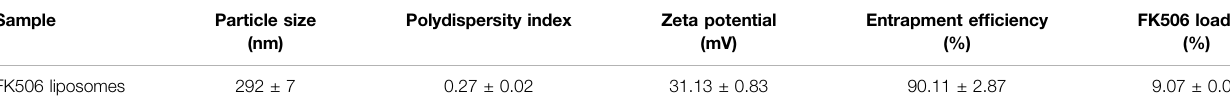
TABLE 1 | Characterization of the FK506 liposome.